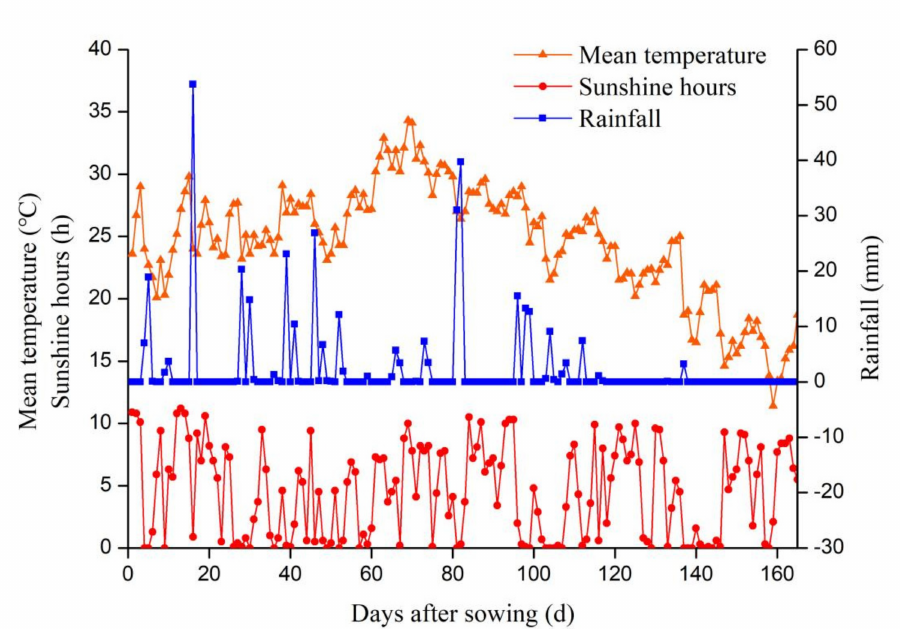
Figure 1. Daily mean temperature, sunshine hours, and rainfall during the rice growing season in 2019, Yangzhou City, Jiangsu Province,